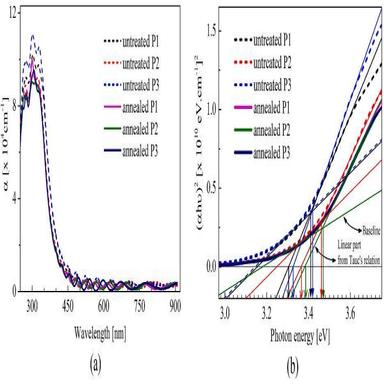
(a) Absorption spectra and (b) plot of (αhυ) 2 versus hυ obtained from three locations on the untreated (dashed-line) and annealed (solid-line) films; evaluated Eg values using Tauc's relation ETauc g (.) and the PE method EPE g (.).